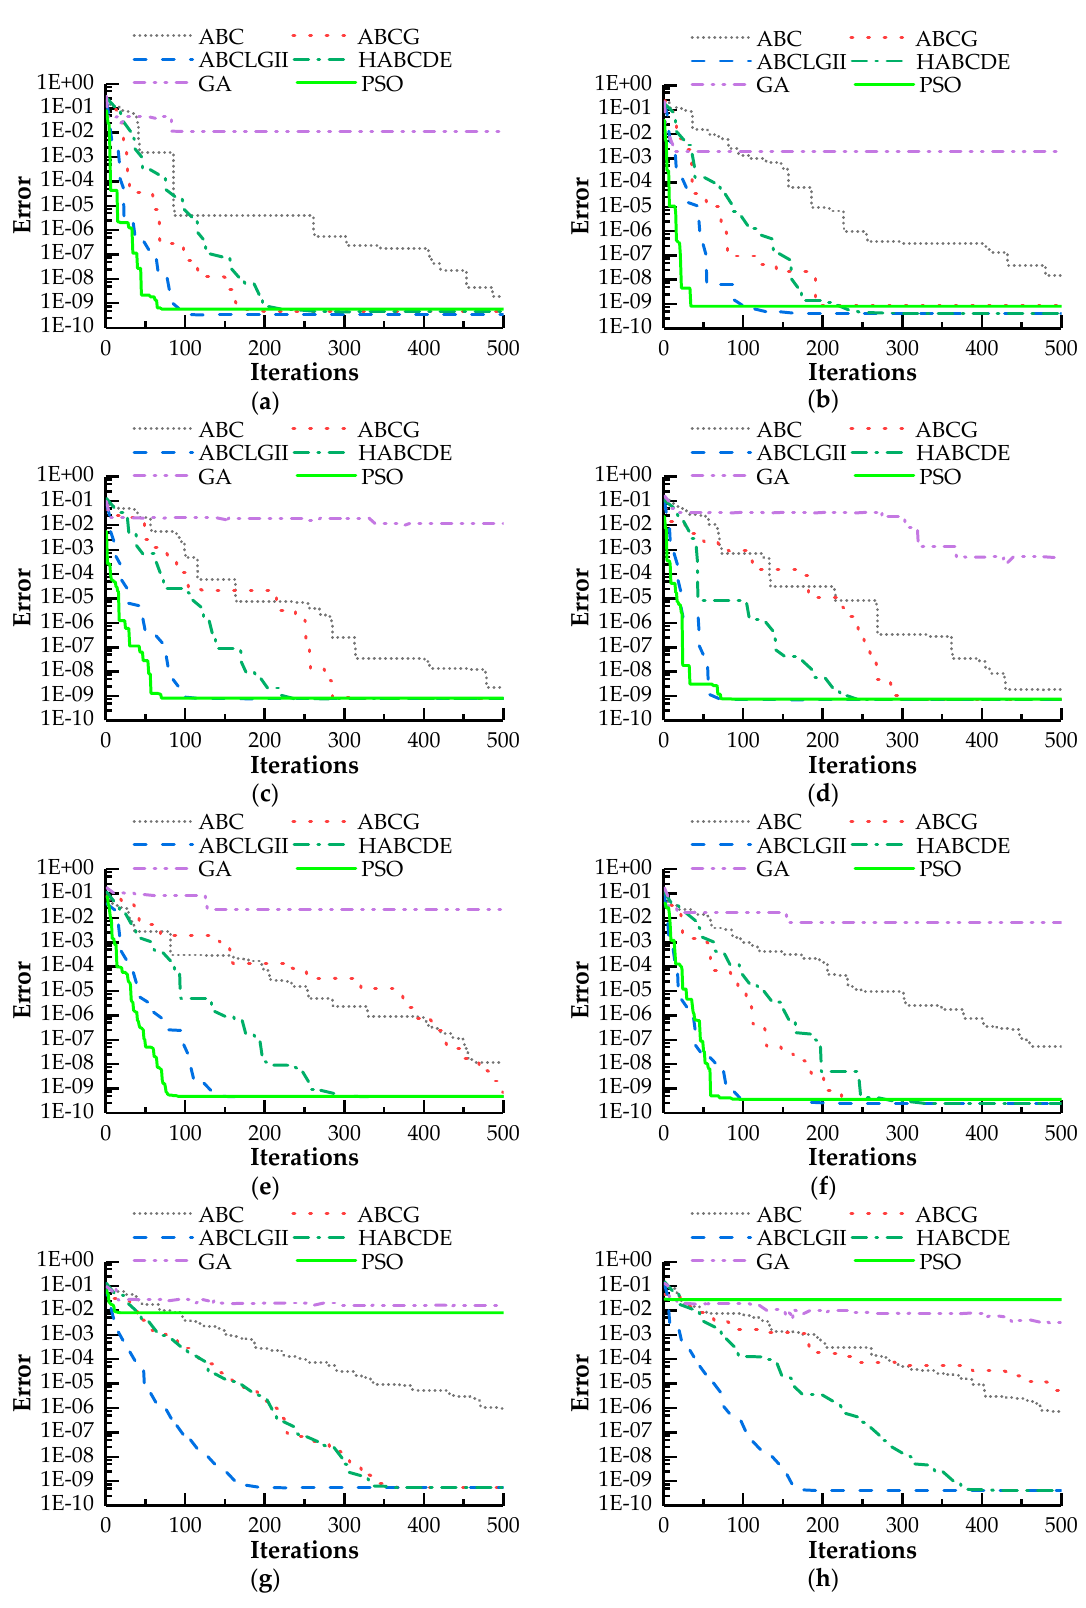
Figure 13. Iteration process of damage identification for Case 5 to Case 8: ( a ) case 5: slab 1; ( b ) case 5: slab 4; ( c ) case 6: slab 2; ( d ) case 6: slab 5; ( e ) case 7: slab 1; ( f ) case 7: slab 3; ( g ) case 4: slab 4; ( h ) case 4: slab 7.